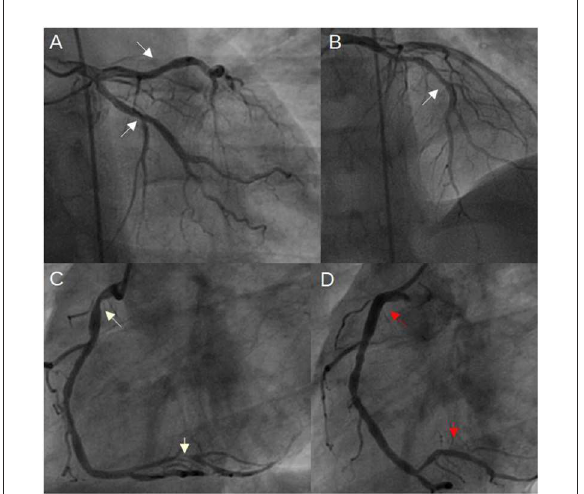
FIGURE1 Coronary angiogram 3 months ago, when inferior wall MI occurred. (A, B) mild coronary artery narrowings in both LCx and LAD (white arrows); (C) severe narrowings in the RCA (white arrows); (D) RCA after stents implantation (red arrows indicate both implanted stents) (LAD, left anterior descending artery; LCx, left circumflex artery; MI, myocardial infarction; RCA, right coronary